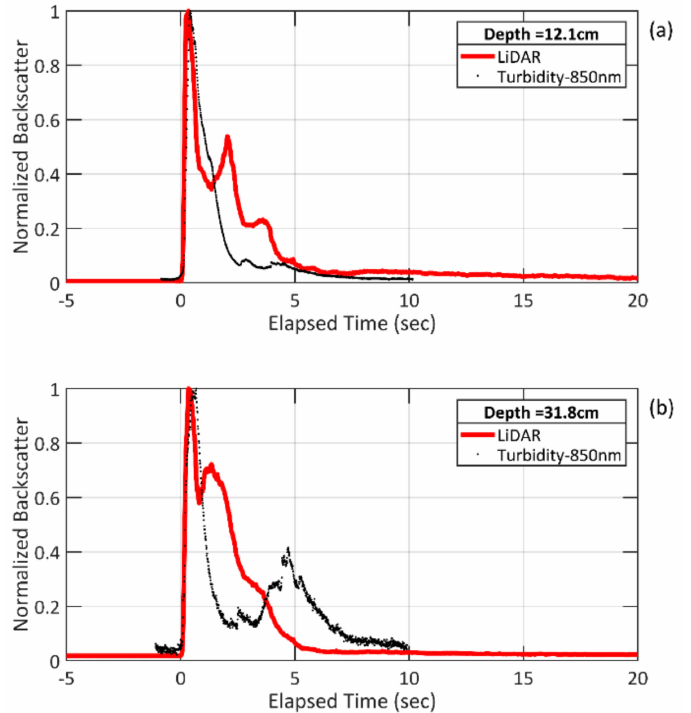
Figure 5. Time series of normalized backscatter intensity of LiDAR and OBS turbidity at depths of ( a ) 12.1 cm and ( b ) 31.8 cm. The sampling rate of turbidity is 100